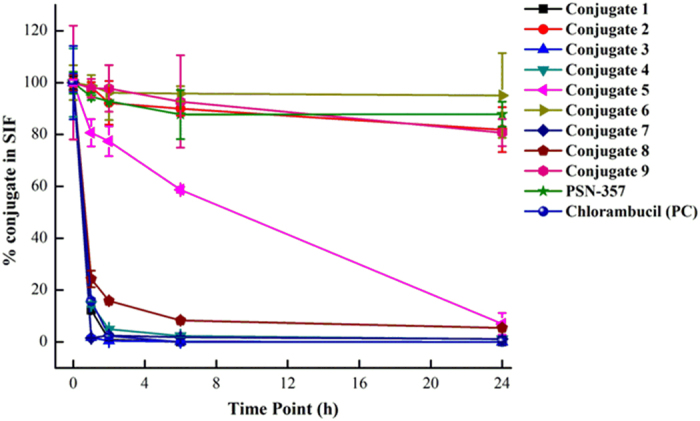
Time-course of SIF stability for conjugates 1–9 (n = 3).